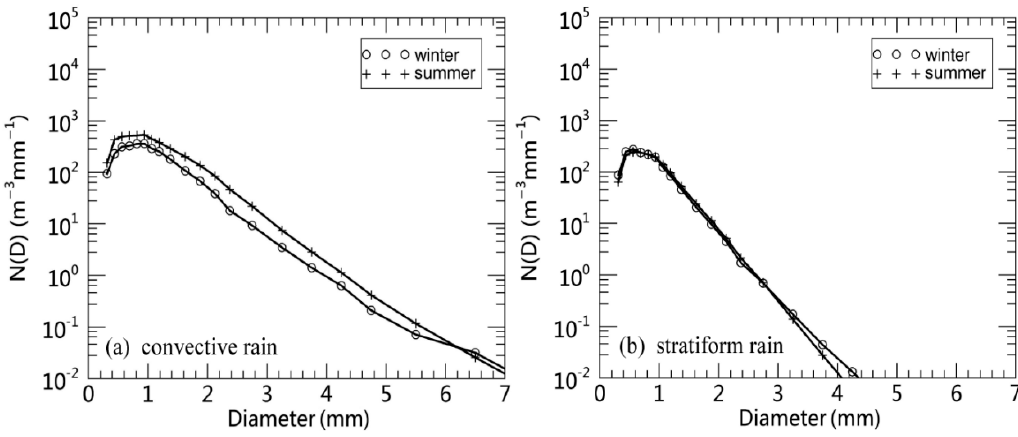
Figure 8. The average DSDs of two indicated rain types: ( a ) convective rain, ( b ) stratiform rain. Table 6. Statistical results of gamma model parameters in terms of two rain types. SD and SK represent standard deviation and skewness, respectively.